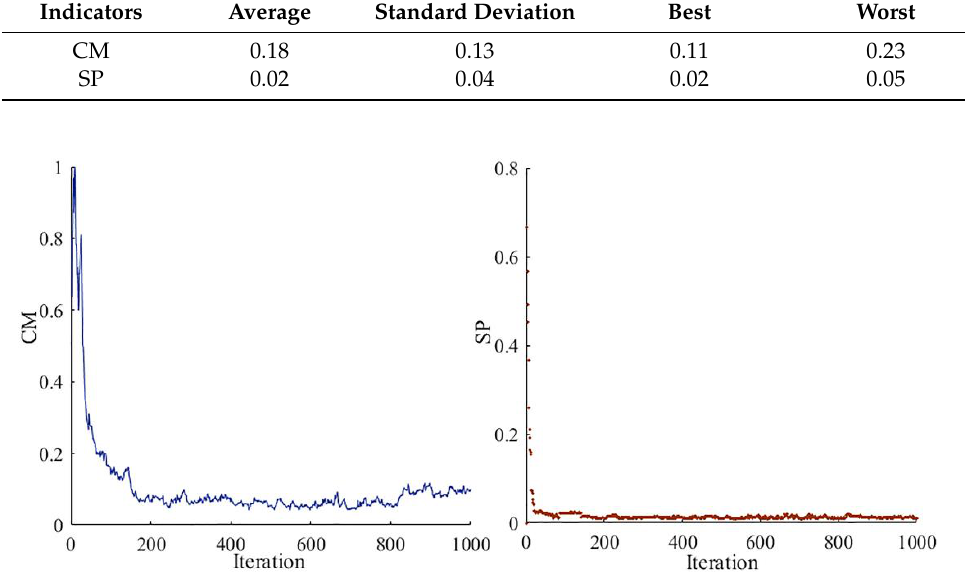
Figure 2. Convergence Trend of the Two Performance Indicators.